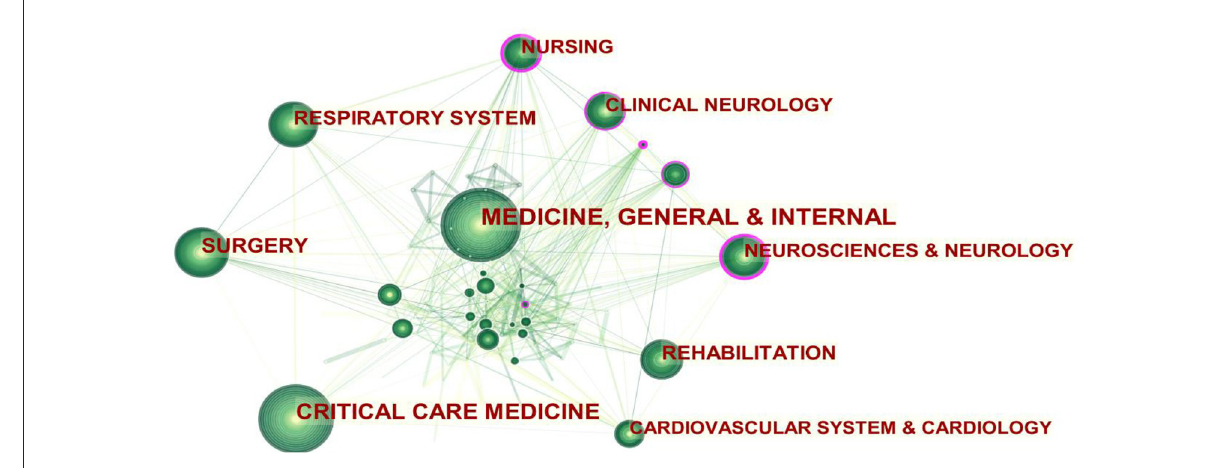
FIGURE2 Subjective categories co-occurrence network mapping (larger circles indicate more publications; purple circles indicate key nodes, i.e., centrality ≥ 0.1. The higher the centrality of a node, the more influential and important it is).